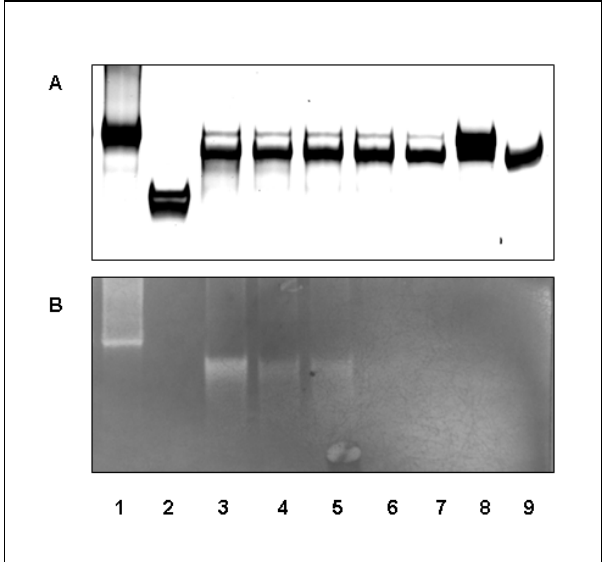
Figure 2. Digestion of the phosphorylated strand of dsDNA with 25 U lambda exonuclease and different digestion times.